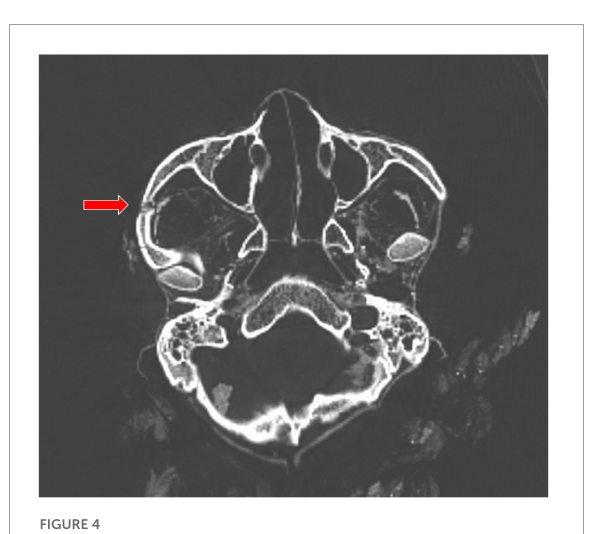
FIGURE4 The right zygomatic fracture